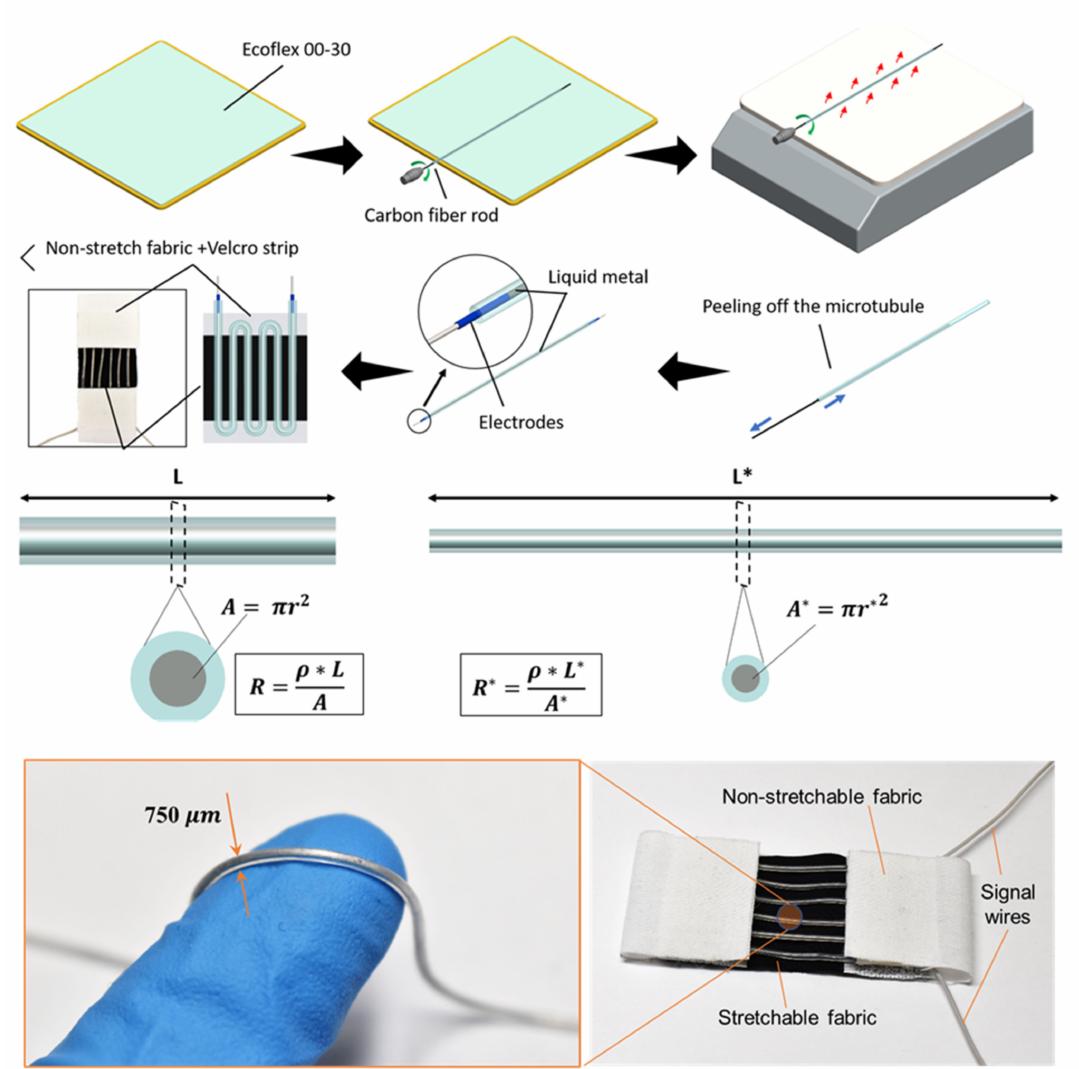
Figure 7. The fabrication process and prototype of the liquid metal-based soft fabric